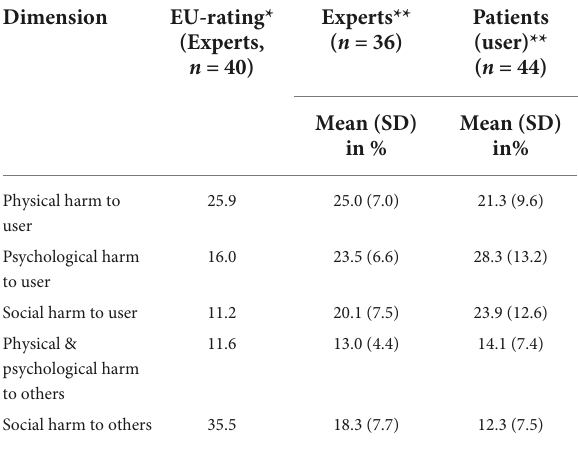
TABLE 1 Relative weights of harm dimensions, as determined by German addiction experts, patients, and EU experts. Dimension